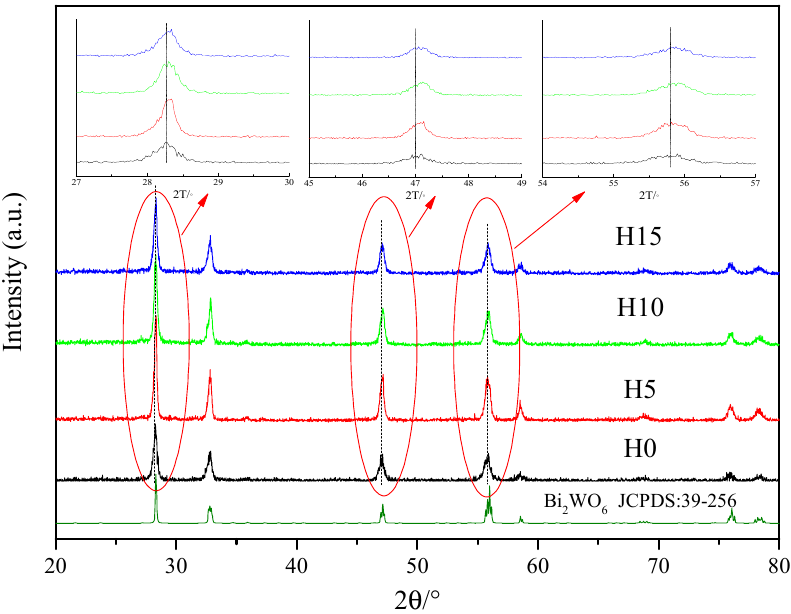
Figure 1. X-ray diffraction (XRD) patterns of Bi 2 WO 6 samples prepared by different HNO 3 concentrations. H0, H5, H10, H15 represent the samples prepared by adding 0 mL, 5 mL, 10 mL, 15 mL HNO 3 with certain concentrations (the details can be found in the sample preparation section).